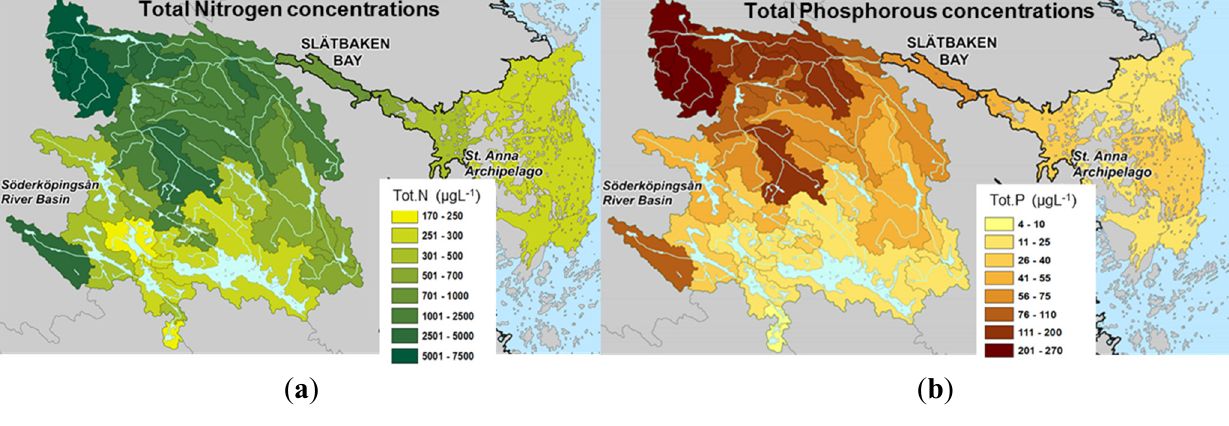
Figure 3. Spatial distribution of modelled surface-water concentrations of total N ( a ) and Total P ( b ) in the Söderköpingsån catchment, the Slätbaken Bay and St. Anna Archipelago (average values for all depths are